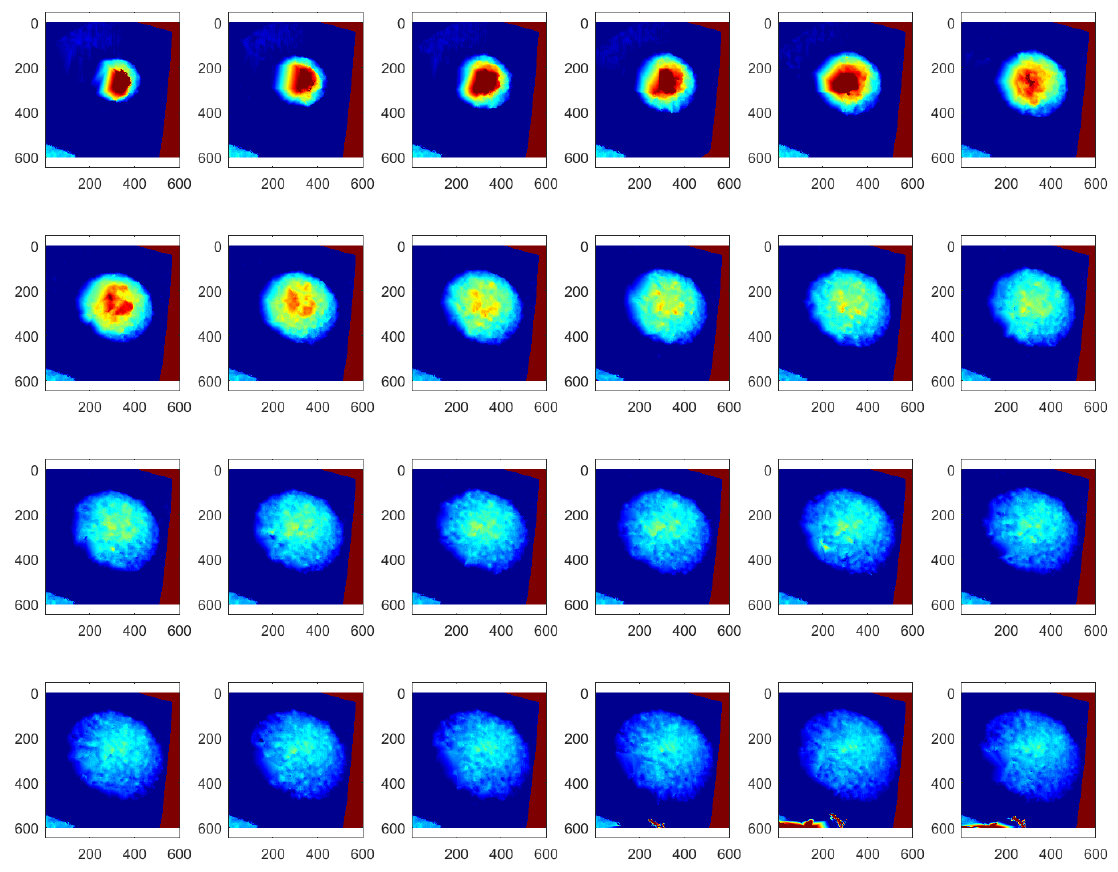
Figure 12. Reconstructed images of the concrete surface over time during the slump flow test (top view). Sensors 2018 , 18 , x